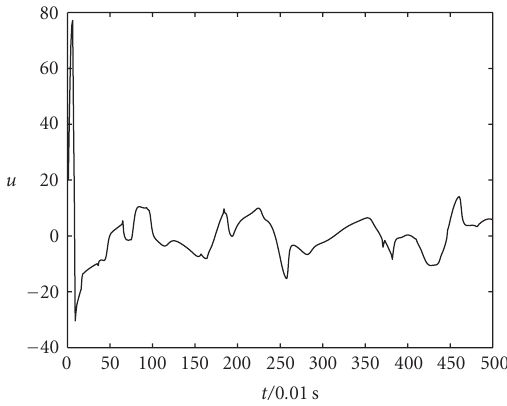
Figure 4.5. Control in periodic-signal tracking.